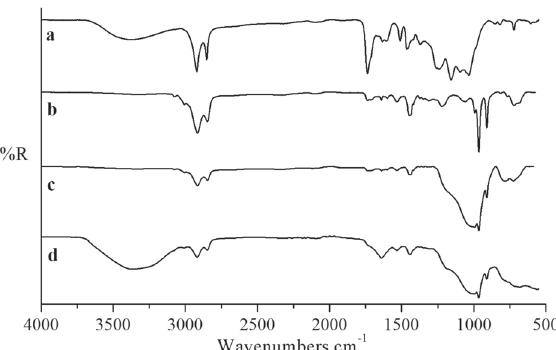
Figure 5 - FT-IR/UATR spectra of: a ) Cork powder; b ) CP5 after the ablation; c ) PExp5/CP3 after the ablation; d ) PExp5/ CP5 after the